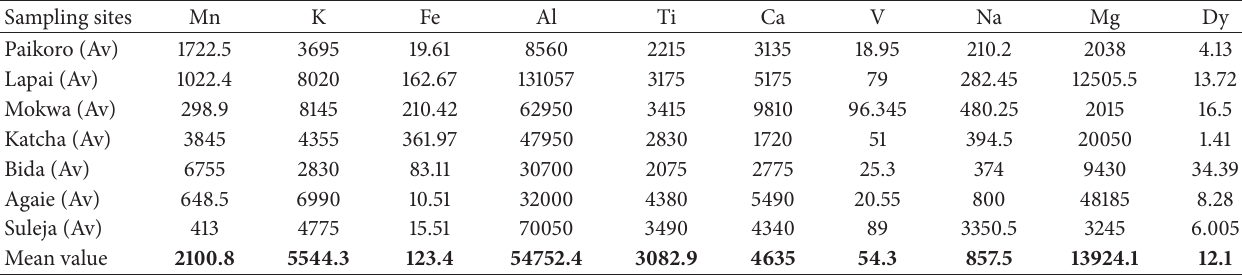
Table 6: Average elemental concentration per